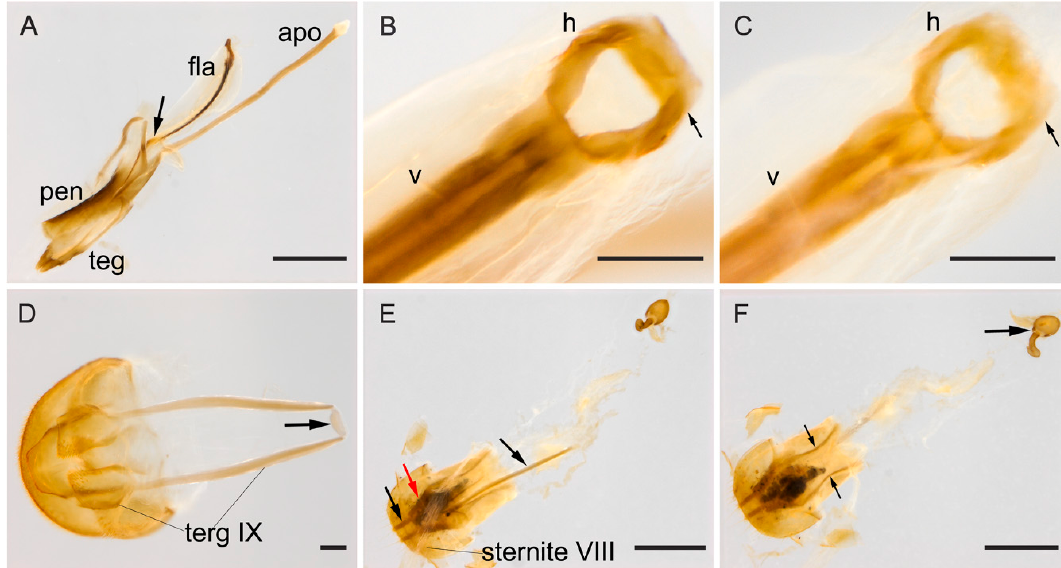
Figure 9. ( A – D ) Male abdominal terminalia of two specimens of Mycotretus tigripennis Mader, 1942 from Piraí, RJ, Brazil: ( A ) lateral view of the aedeagus, showing apophyses (apo), flagellum (fla), penis (pen) and tegmen (teg); arrow showing a shallow desclerotization posteriorly. ( B – C ) Flagellum dorsal view, showing: head (h) and anterior tip of virga (v); arrow showing the outer anterior contour with an acute angle. ( D ) Abdominal segments VIII–X: laterotergite IX (terg IX), arrow showing the sclerite at the anteroventral edge of segment IX. ( E – F ) Female abdominal terminalia of a specimen from Piraí, RJ, Brazil: ( E ) dorsal view, big arrow showing the median strut of sternite VIII, small black and red arrows showing a gonostylus and a gonocoxite, respectively; ( F ) ventral view, small arrows showing baculi of paraprocts and big arrow showing the spermatheca. Scale bars: A , E – F = 0.5 mm; B – D = 0.1 mm.